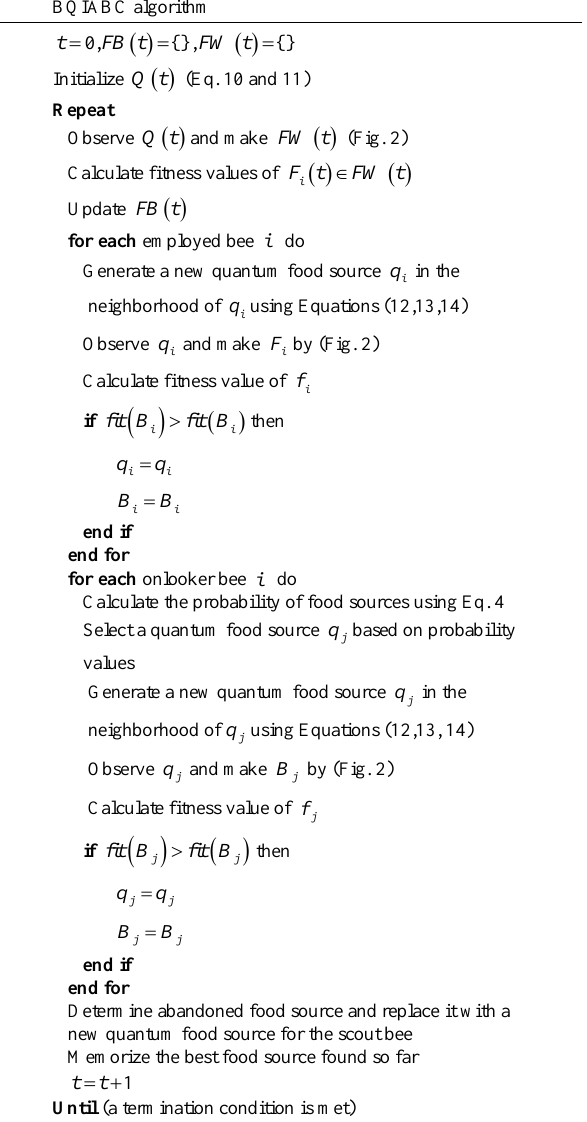
Figure 3. Pseudo code of BQIABC